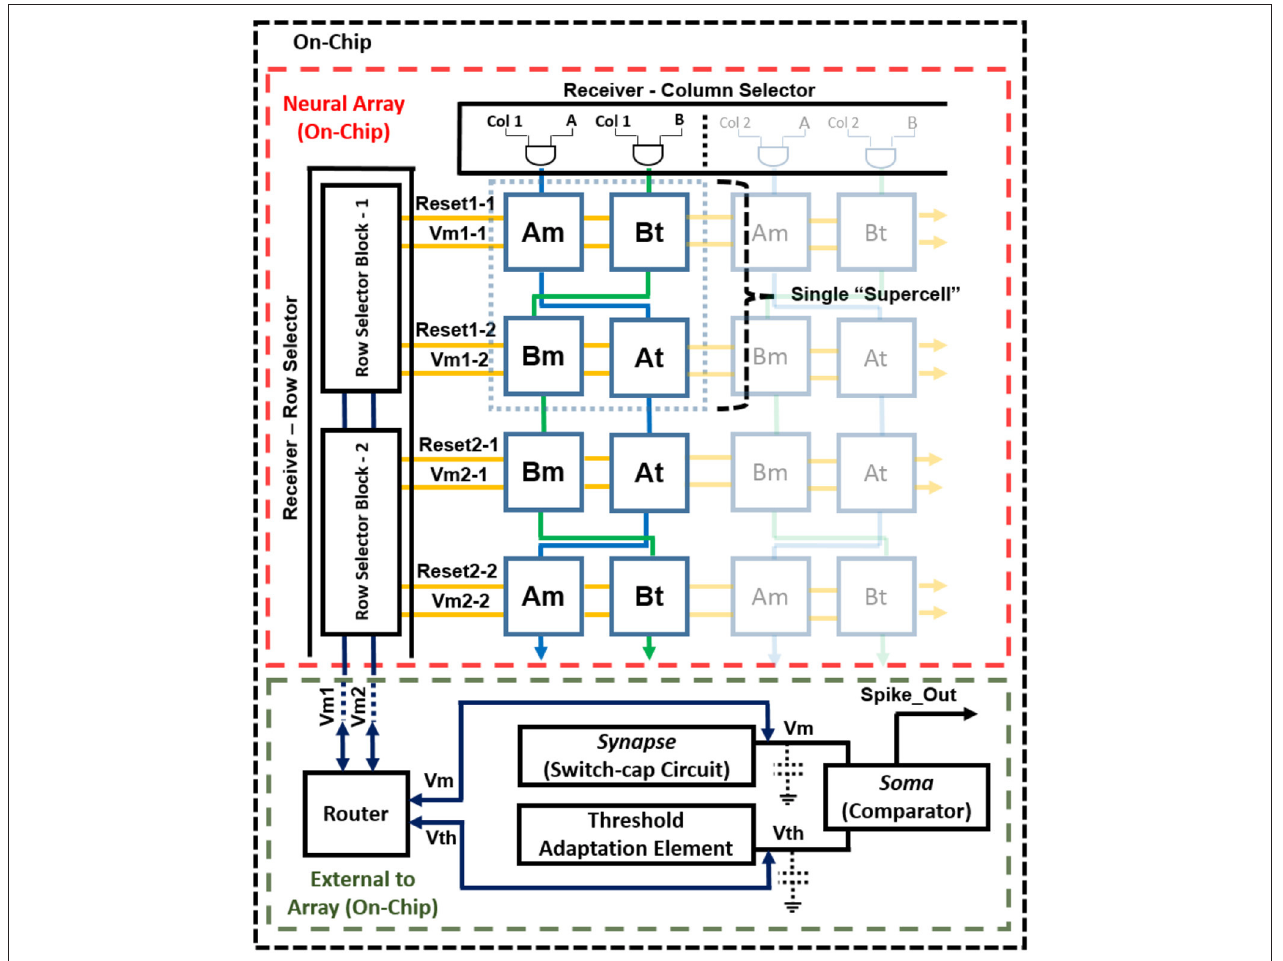
FIGURE 1 | Mihalas–Niebur neural array